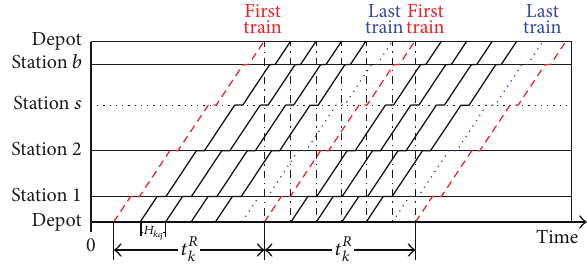
Figure 3: Train connection on loop